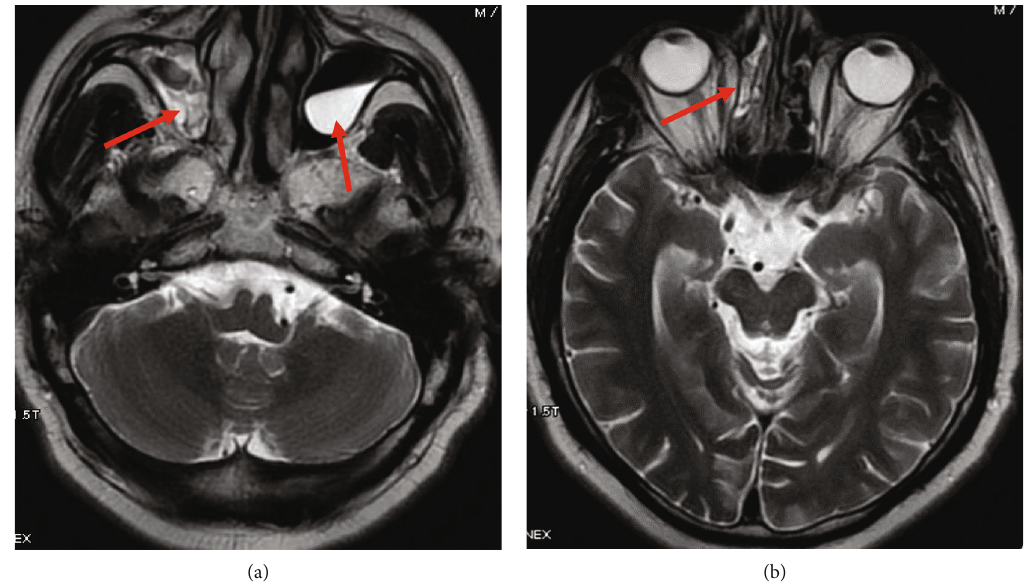
Figure 2: Axial T2-weighted images without contrast administration show (a) mucosal thickening and secretion in the right maxillary sinus and a retention cyst in the left maxillary sinus and (b) mucosal thickening and secretion in the right ethmoid sinus with a lesser degree in the left ethmoid sinus.